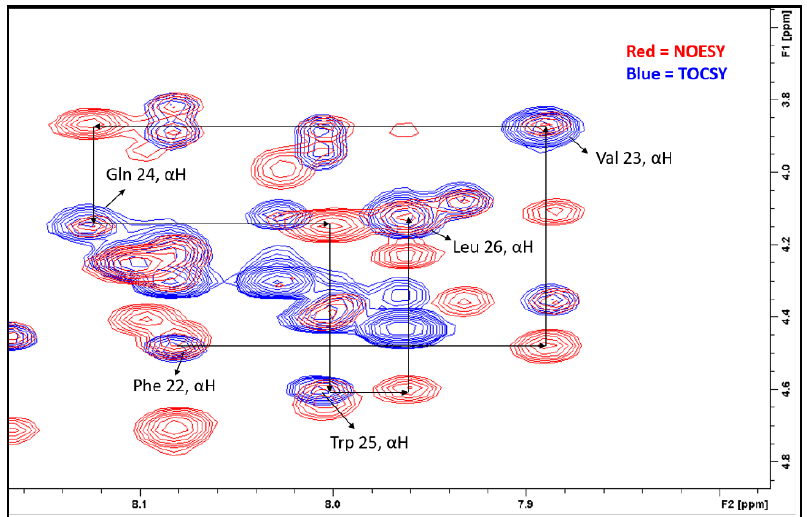
Figure 2. TOCSY and NOESY overlaid spectra demonstrates the sequential walk for the α -H on Phe 22 Val 23 Gln 24 Trp 25 Leu 26 .